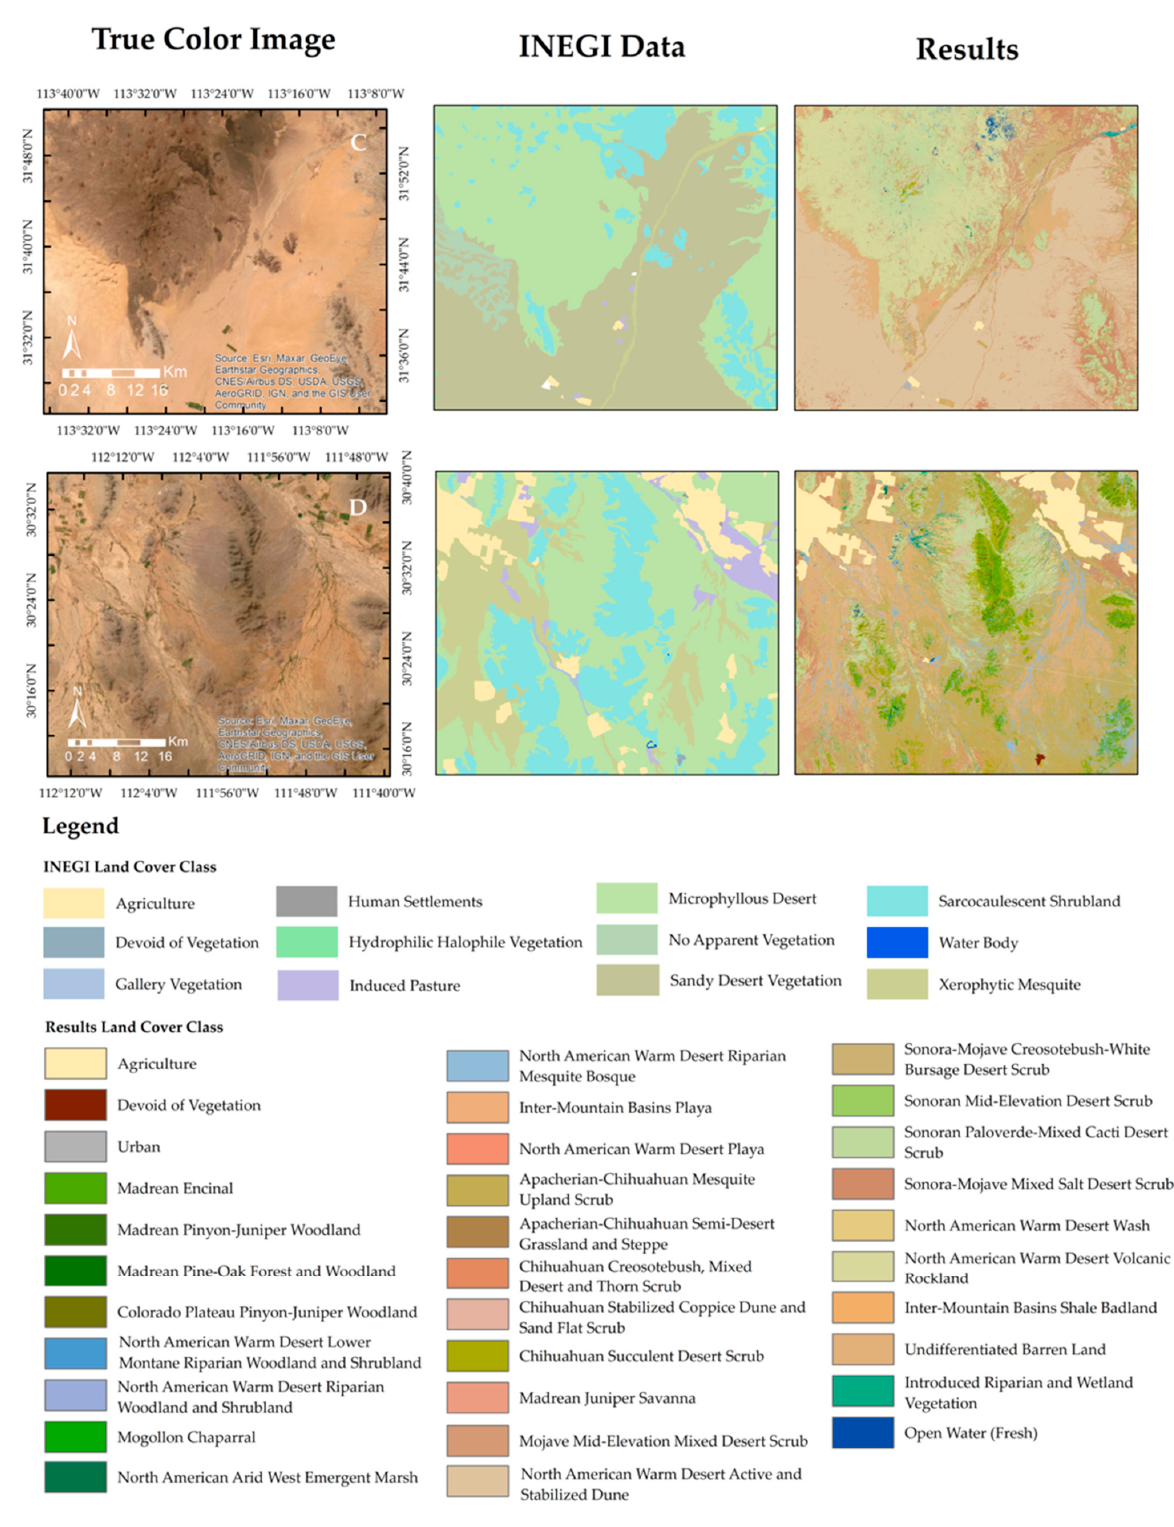
Figure 8. Zoomed-in comparisons of true color imagery ( left ), INEGI data ( middle ), and results of the RF model ( right ) within MX regions of the study area. The legends provided represent only the classes shown within the areas. The locations of each area are identified in subregions ( C ) and ( D ) of Figure 7. Table S1, provided as Supplemental Material for this publication, shows the comparisons made between classes of the resulting land cover classification system and the INEGI classification